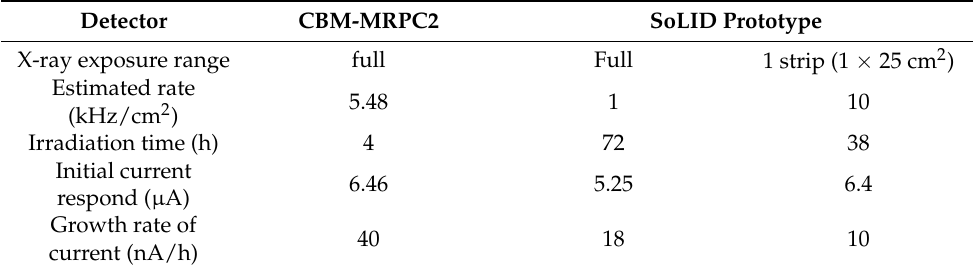
Table 2. The summary of the current behavior tests in X-ray